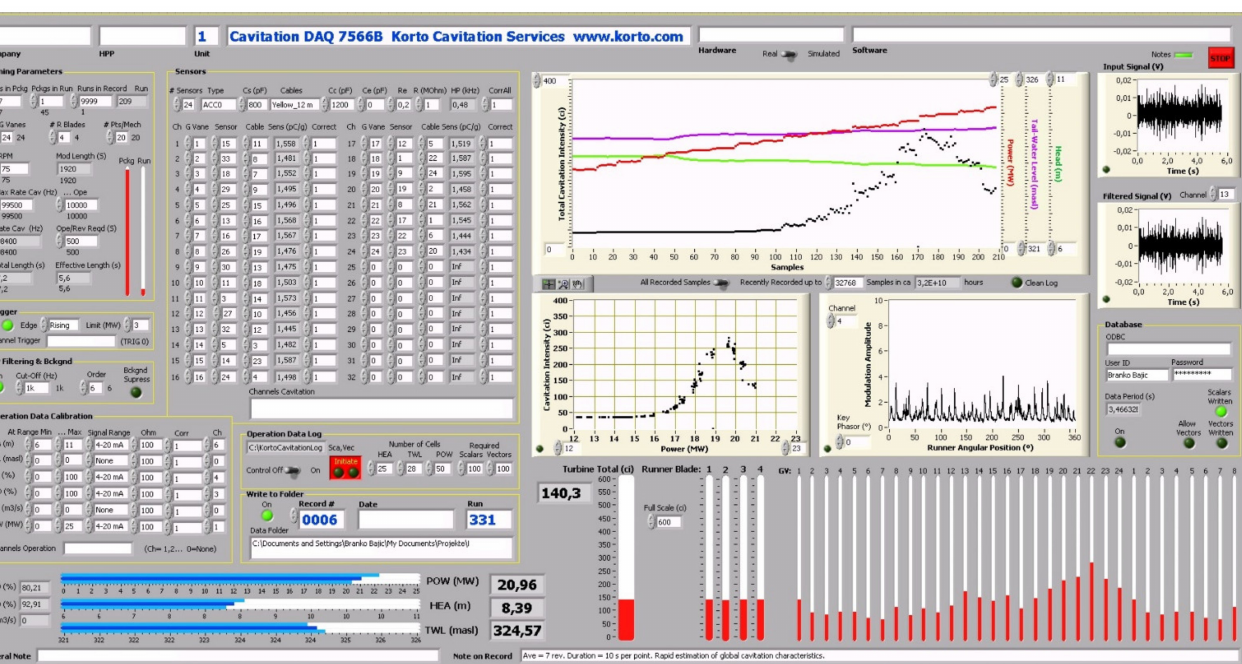
Figure 3. Front panel of the multidimensional data acquisition processor. The simplest description of cavitation comes out online after half an hour of measurement on the prototype. More complicated descriptions require days or weeks of recorded data analysis by a trained user.